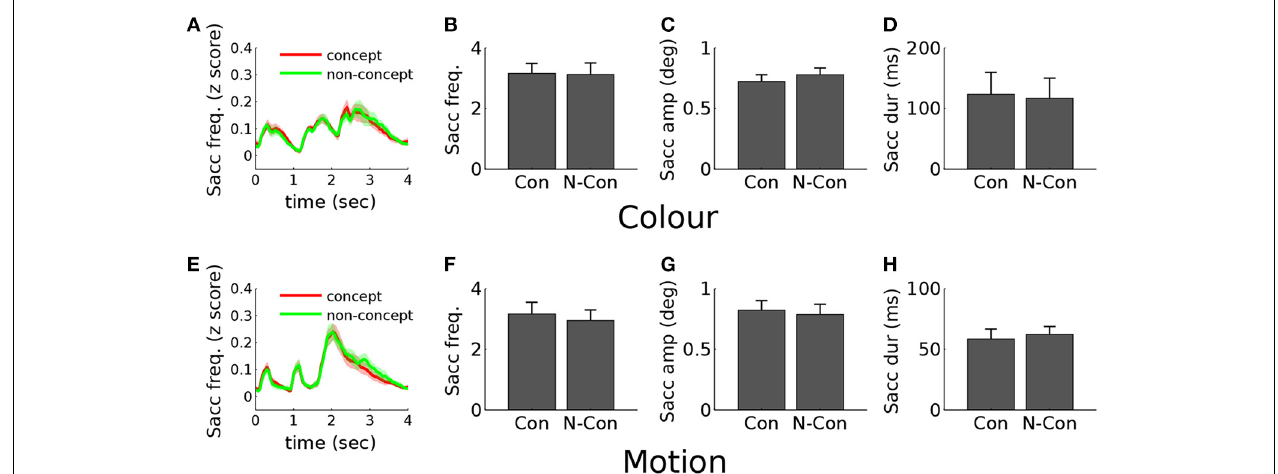
FIGURE 8 | Eye movement results. (A) Concept (red) and non-concept (green) saccade frequency profiles for color stimuli plotted from 0 (trial onset) to 4s post-onset. Stimuli were displayed within the first 2.1s, and responses (button presses) made within the following period (2–4s post-onset).